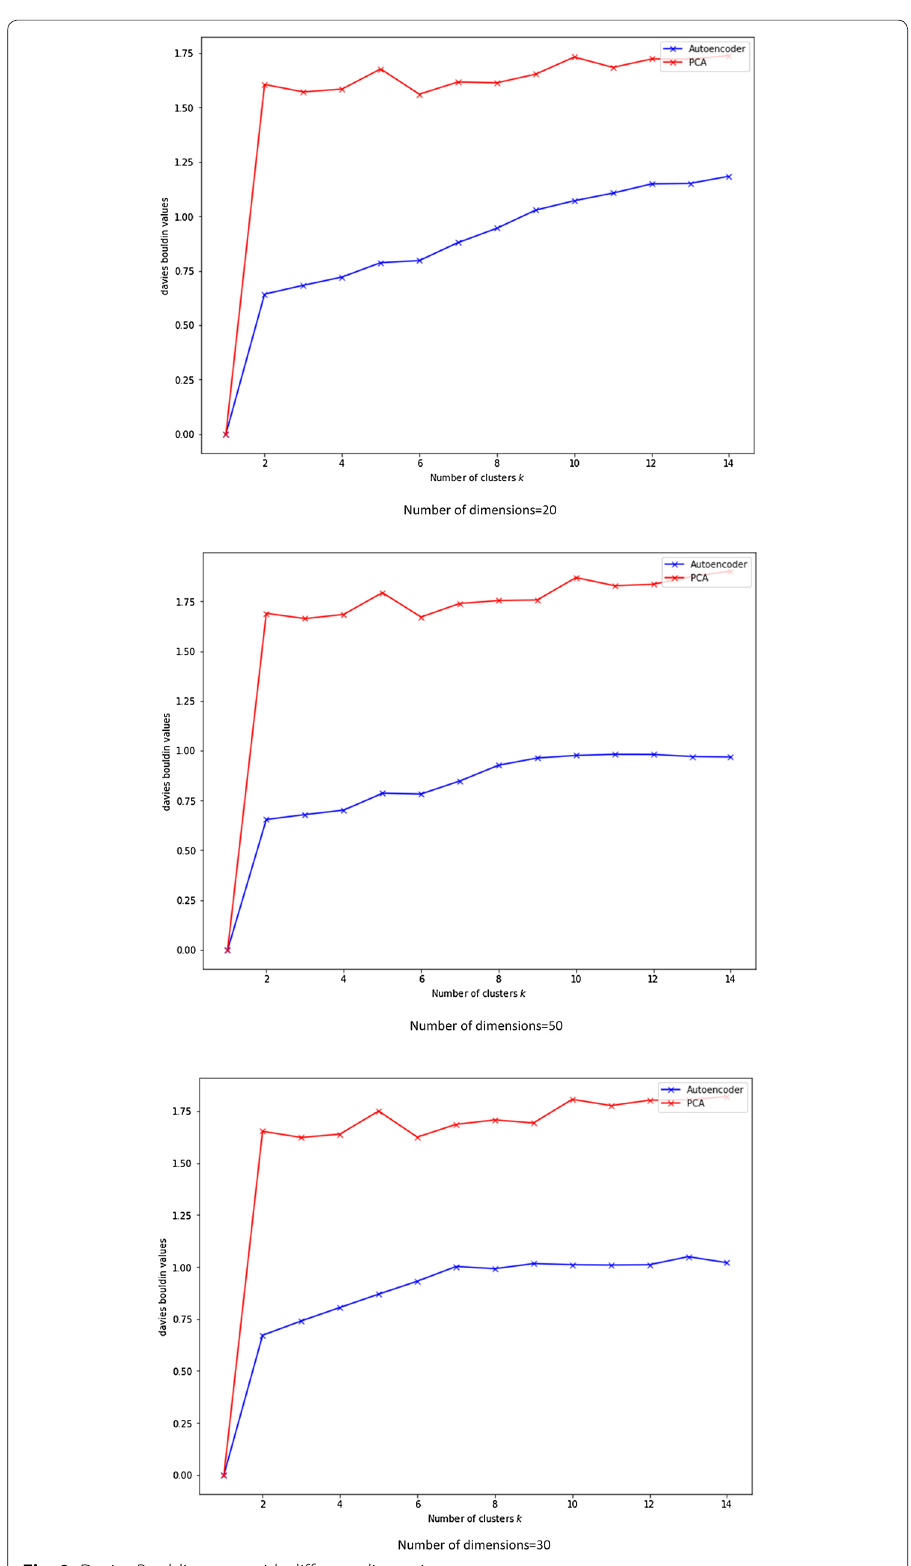
Fig. 9 Davies Bouldin score with different